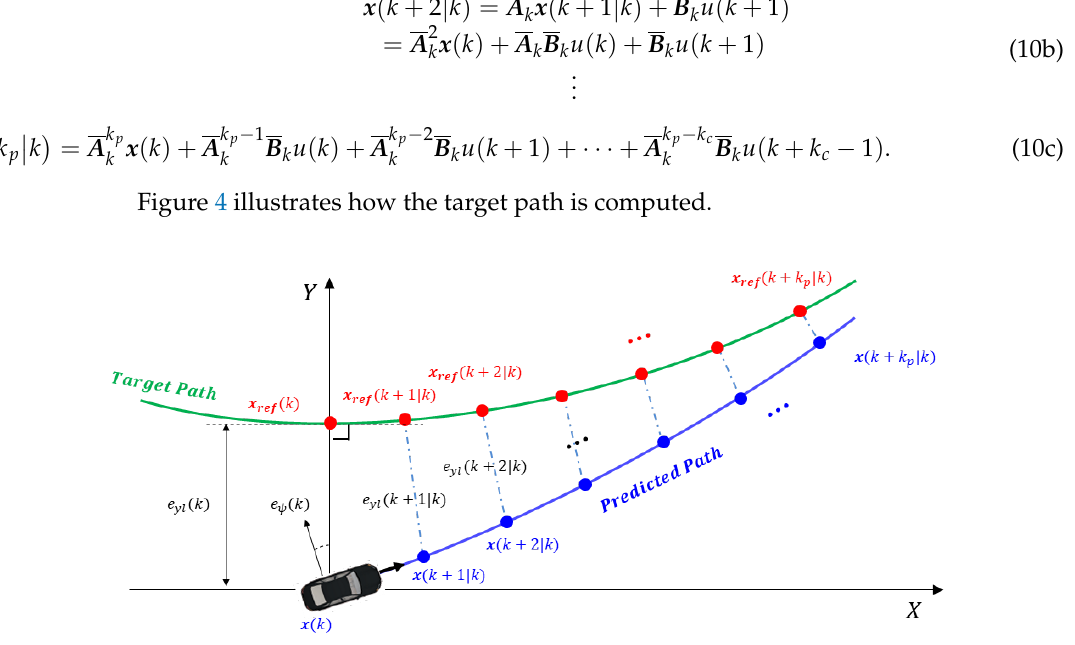
Figure 4. Target path and predicted path of the vehicle.